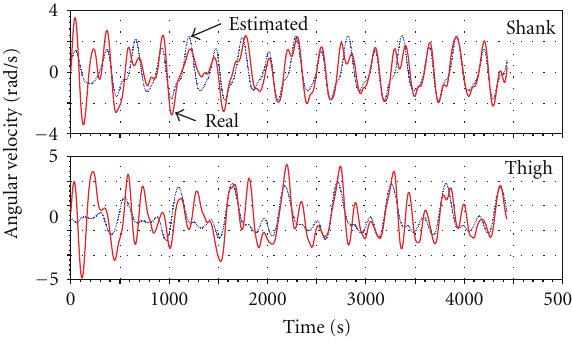
Figure 9: Motion estimation of IBL.